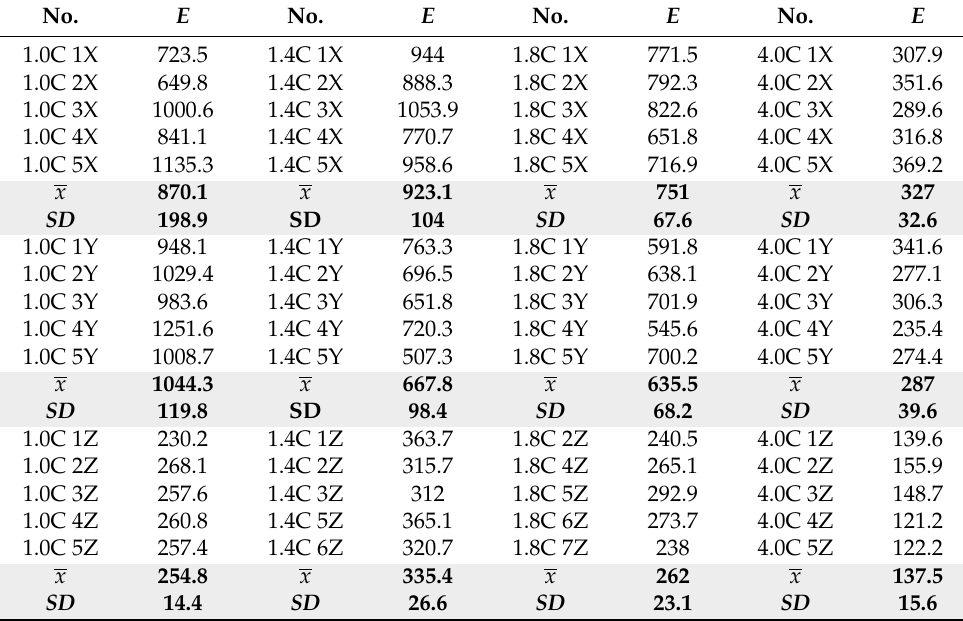
Table 7. Elasticity modulus (in MPa) for the PLA-CF